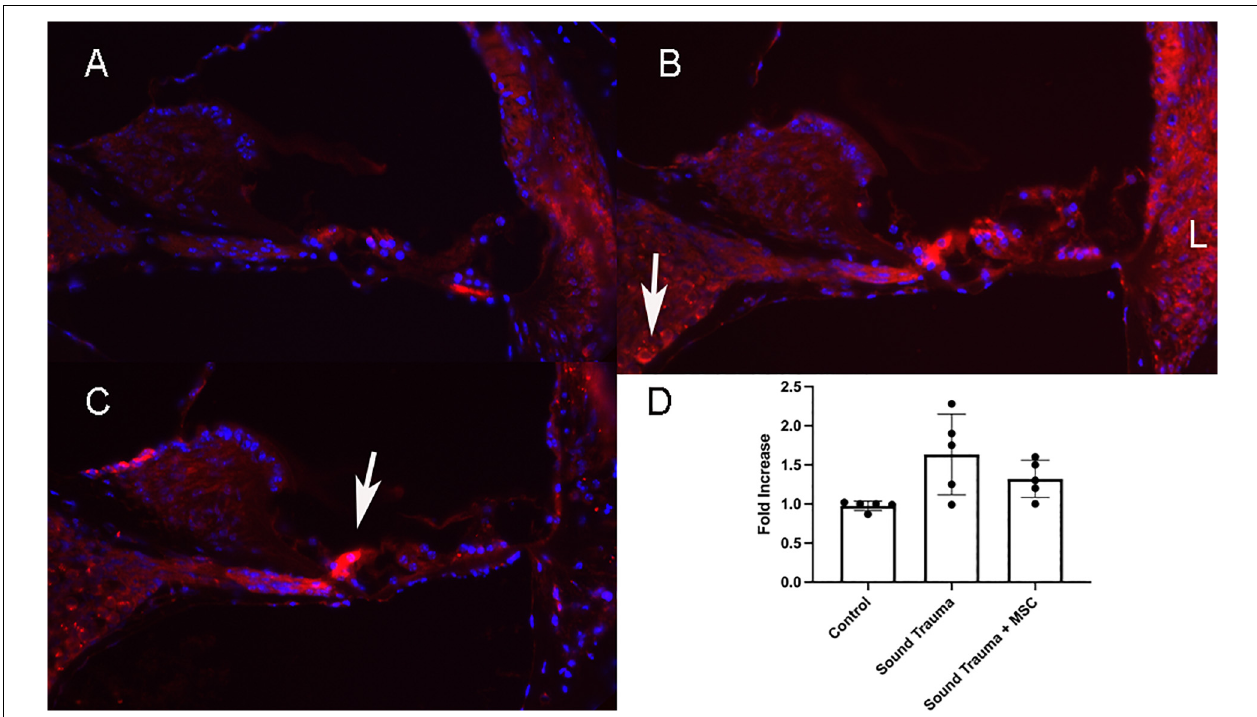
FIGURE 7 | Expression of TNF α protein (Red A–C ) and semi quantitative RT PCR of TNF α mRNA (D) . Control cochlea showed minimal TNF expression in the hair cells and lateral wall (A) . After sound trauma there was a clear increase in TFN alpha immunolabeling in hair cells, the spiral ganglion (arrow) and the lateral wall (B) . Treatment with MSCs after sound trauma reduced TNF α expression in the lateral wall and outer hair cells but expression remained high in the inner hair cell (arrow C ). Semi quantitative RT-PCR showed an up-regulation of TNF gene expression after sound trauma. This was slightly reduced after MSC treatment but not to control levels (D)